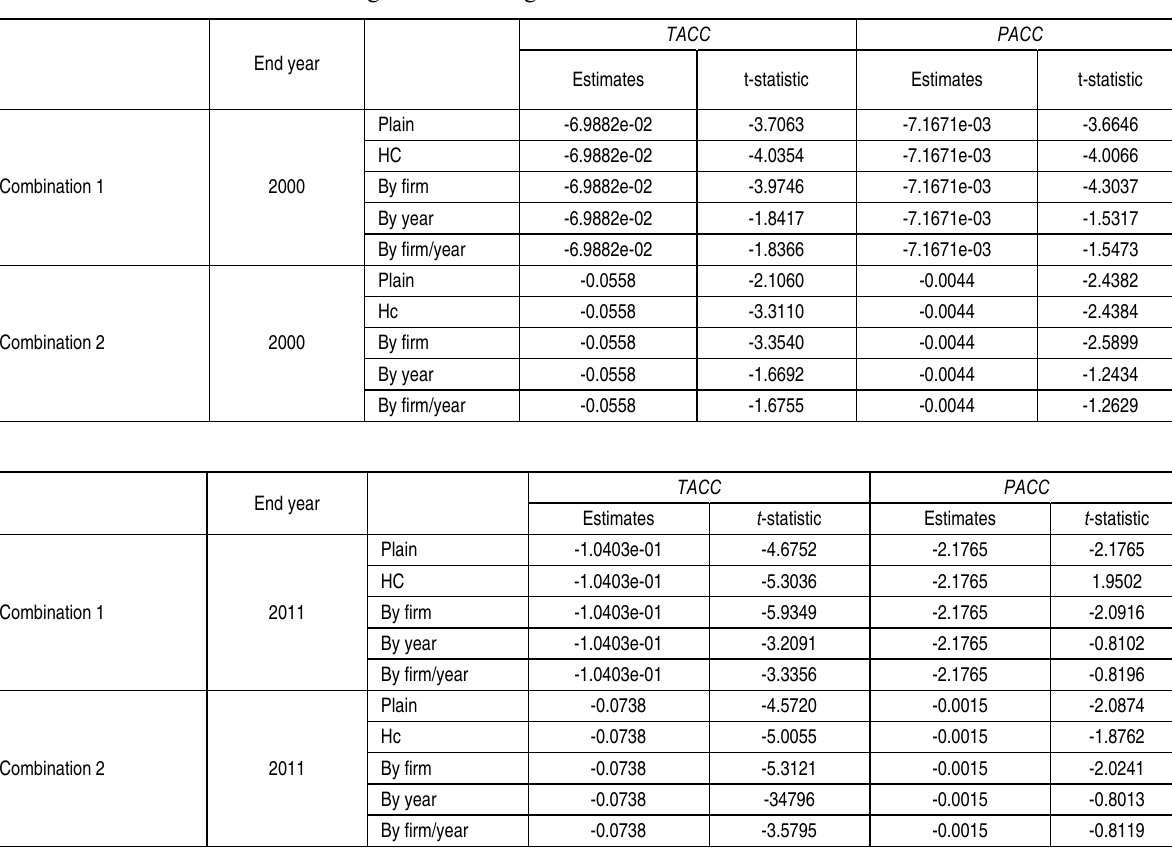
Table 6b. Significance of regression estimates for TACC and